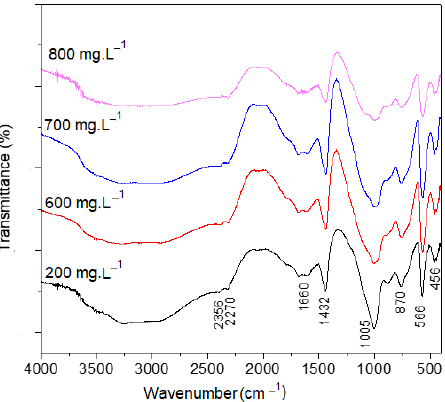
Figure 6. FTIR spectra of the precipitates obtained for different initial phosphorus concentrations, a stirring rate of 100 rpm, and a solution volume of 600 mL.